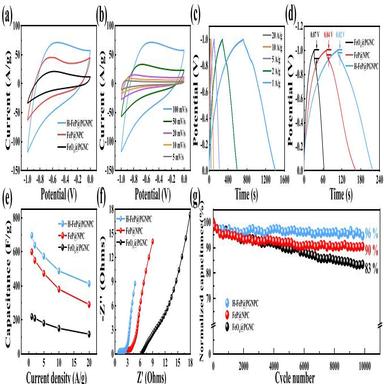
a) CV curves of Fe@NC, FeOx @PGNC and H-FeP@PGNPC at the scan rate of 100 mV s−1. b) CV curves of H-FeP@PGNPC at different scan rates. c) Galvanostatic charge/ discharge curves of H-FeP@PGNPC at different current densities. d) Galvanostatic charge/discharge curves of all samples at 5 A g−1. e) specific capacitances of Fe@NC, FeOx @PGNC and H-FeP@PGNPC at different current densities. f) Nyquist plots in a frequency range from 0.1 Hz to 100 kHz for all samples. g) Cycling stability of all samples at a current